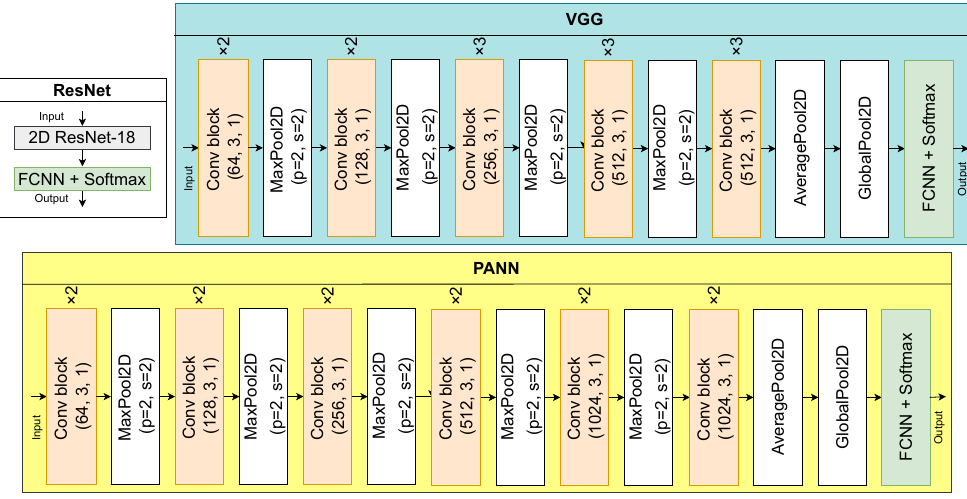
Figure 4. Model architectures for audio speech